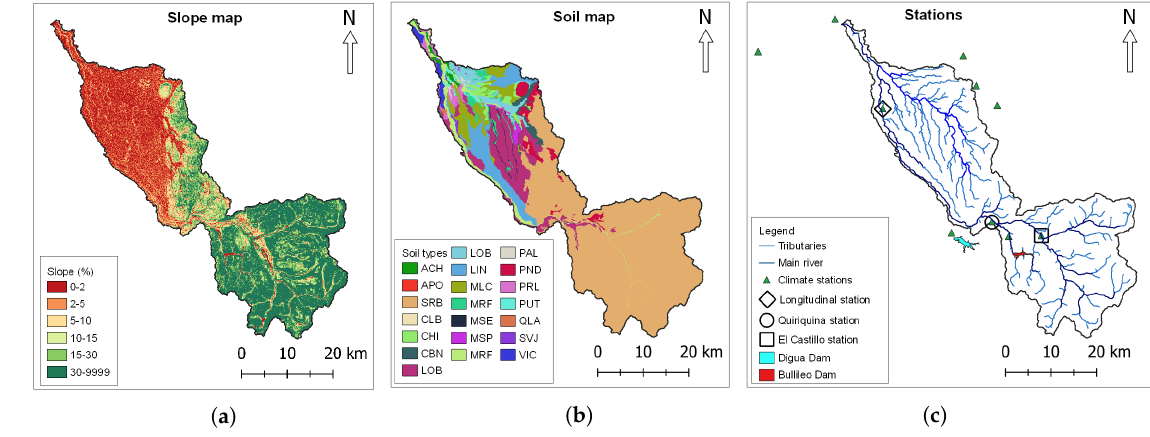
Figure 2. ( a ) Slope map, ( b ) soil type map and ( c ) stations on the Longaví catchment. Table 2. General description of the soils in the Longaví